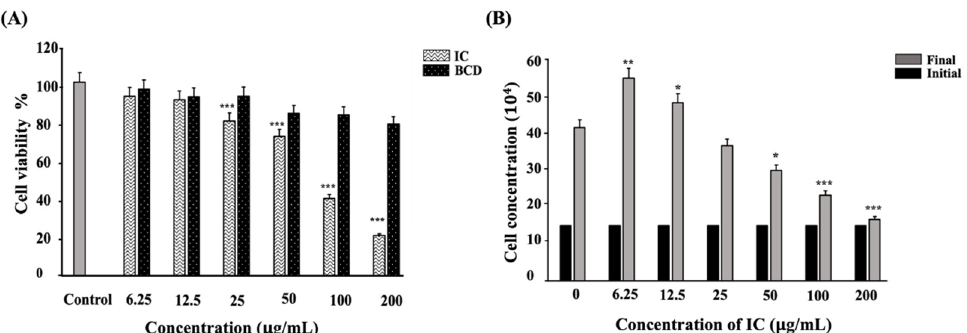
Figure 4. Lower concentrations of IC exhibited cytocompatibility and improved proliferation ( A ) C2C12 myoblasts treated with BCD and IC separately for 24 h prior to MTT exposure and measured spectrophotometrically at 570 nm. ( B ) C2C12 myoblasts were treated with IC, incubated for 24 h, and counted using trypan blue exclusion method to assess the cell proliferation. All the experiments were repeated thrice, and data were shown as mean ± SD; n = 3. *, ** and *** shows a significant difference at p < 0.05, p < 0.01, and p < 0.001, respectively, compared to the control (Two-tailed t